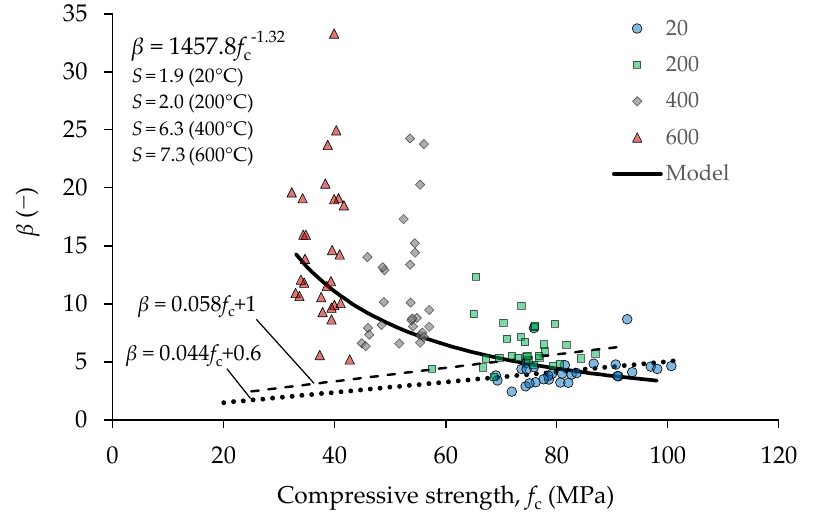
Figure 19. Correlation between parameter β and compressive strength for mixtures M2-M11.